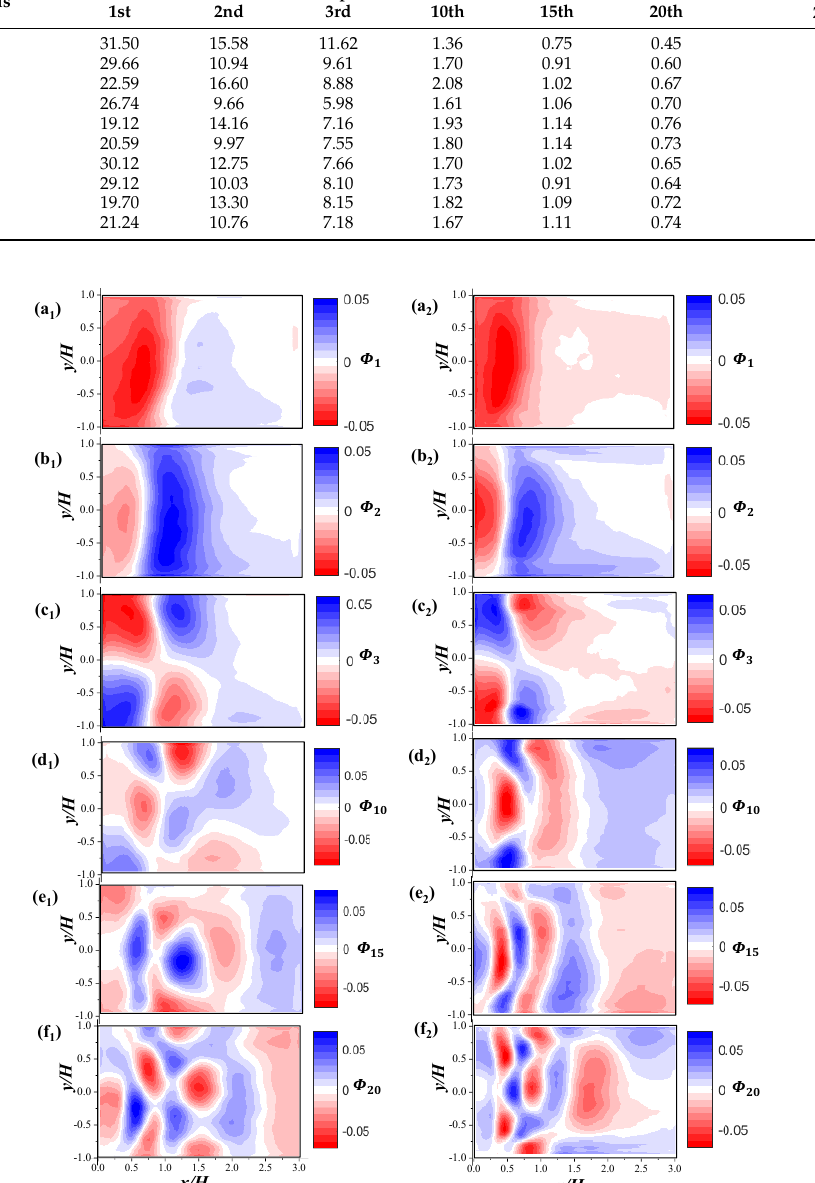
Figure 21. The typical POD eigenvectors of fluctuating pressure for M3. ( a 1 – f 1 ): No_snow; ( a 2 – f 2 ): Snowdrift.